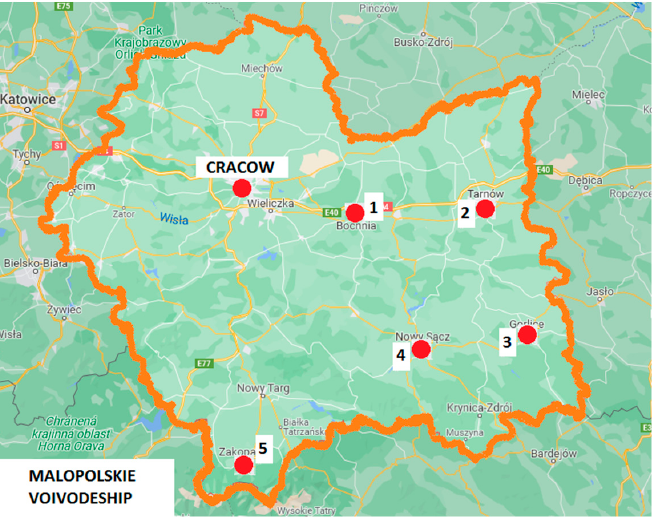
Figure 3. Malopolskie Voivodeship. Cracow and analyzed cities: 1—Bochnia, 2—Tarnow, 3—